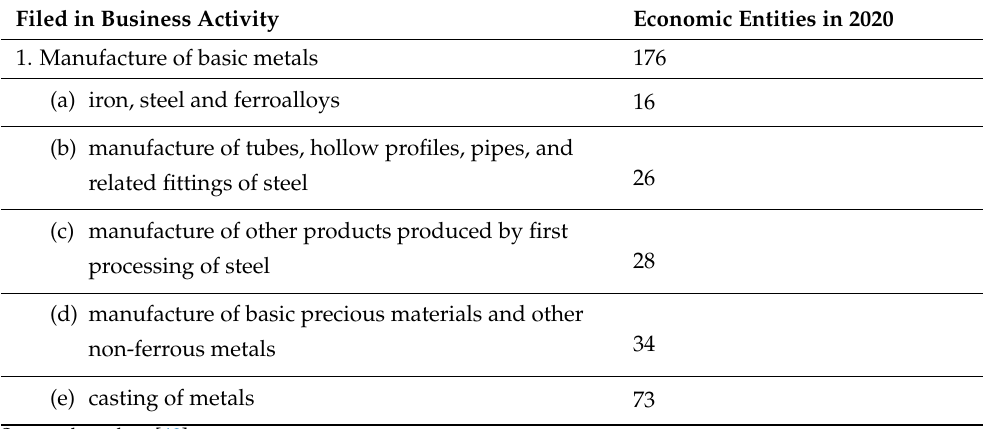
Table 4. Sector of manufacture of basic metals in Poland—statistics